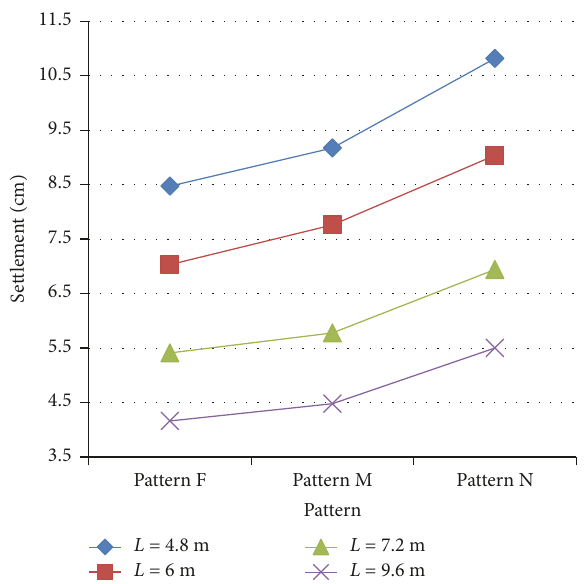
Figure 11: CPRF’s settlements under combined static (90kPa)- dynamic